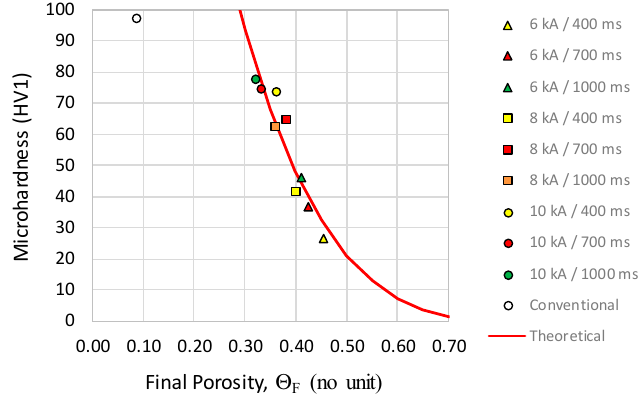
Figure 12. Mean microhardness (HV1) vs. final porosity of the compacts.